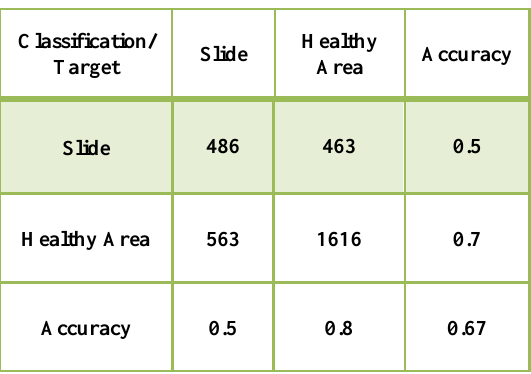
Table 1. Confusion